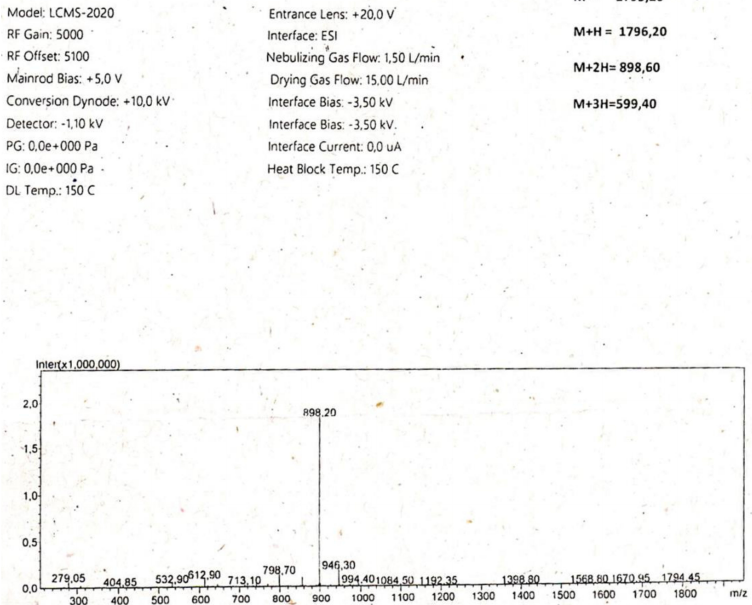
Figure A4. Mass spectroscopy analysis of peptide